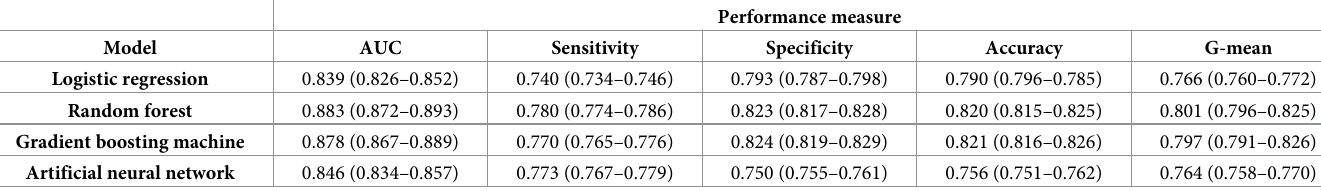
Table 3. Selected models performance on unforeseen test data of 2017/2018 (n =